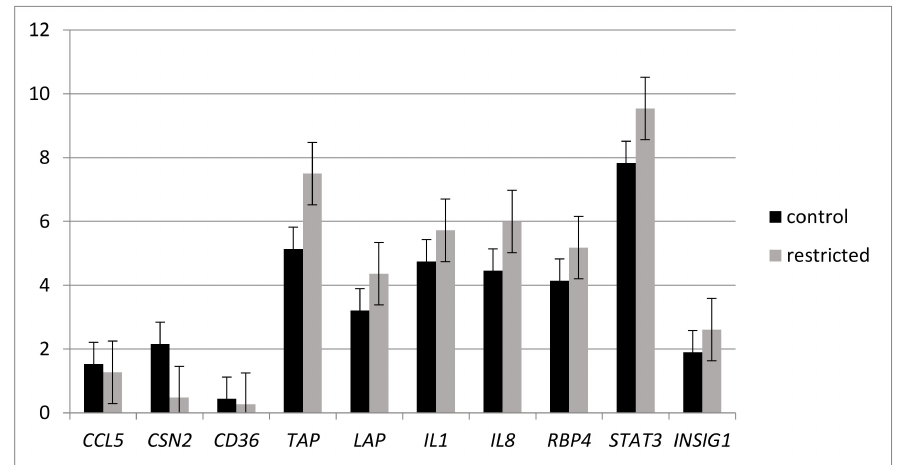
Figure 1. Effects of nutrient restriction and intra-mammary lipopolysaccharide (LPS) challenge on gene mRNA expression quantified by RT-qPCR and presented as ∆ CT . Comparison of the gene expression does not show a difference between control (CONT; n = 6) and restricted (REST; n = 6) Holstein cows ( p ≥ 0.1). The expression of the TAP gene tended to differ ( p = 0.07). UXT2 , CLN3, and EIF3K were used as housekeeping